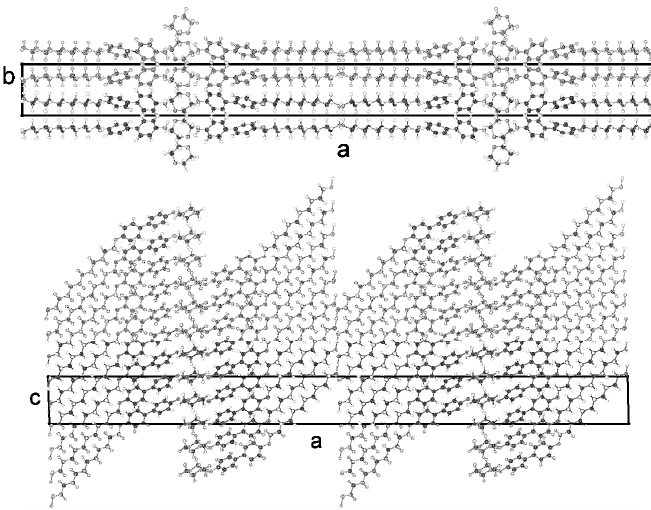
Figure 35. Representation of the crystal structure of H11HBP complexed with 1,4 dioxane in [001] and [010] projection showing a tilted structure such as occurs in smectic liquid crystalline phases. Note the hydrogens of terminal hydroxy groups exhibit partial occupancy both involved in hydrogen